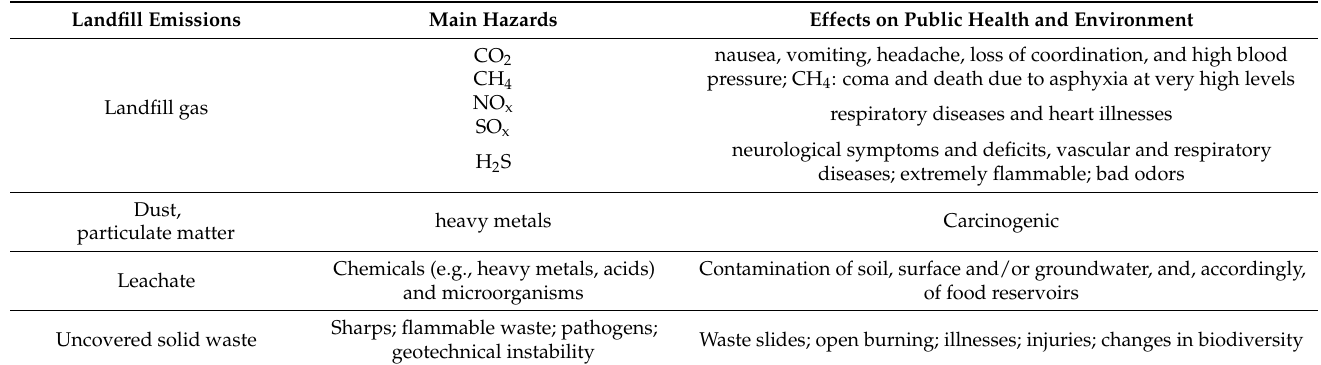
Table 1. Effects of waste dumpsites on public health and environment.